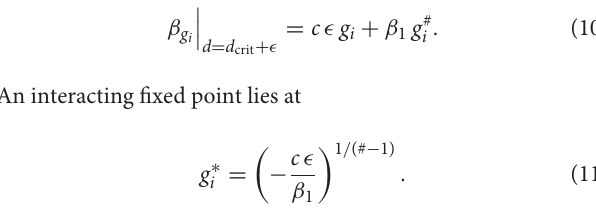
FIGURE 3 | Left panel : The beta functions β g attractive direction. The UV critical surface is indicated in green, the IR critical surface in red. The RG flow toward the IR is attracted toward the UV critical surface, such that the relation between g and y that parameterizes the UV critical surface is approximately realized also for trajectories (in purple) that start off the UV critical surface. Right panel : The flow described by β g UV critical surface has no curvature. Therefore, g 2 ( k )